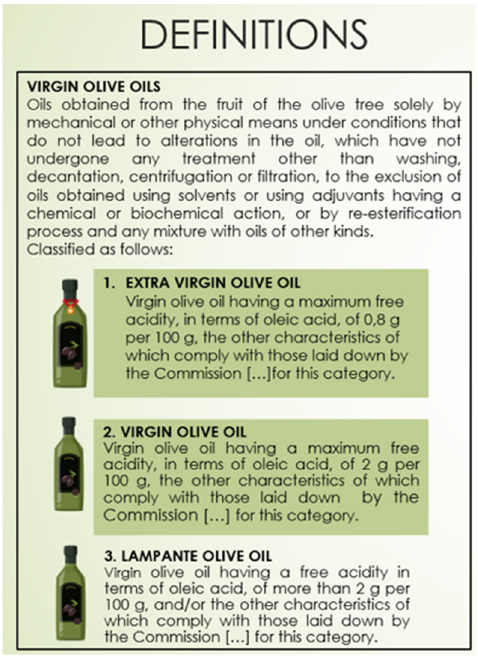
Figure 5. Example of detailed documentation of the olive oil milling process.